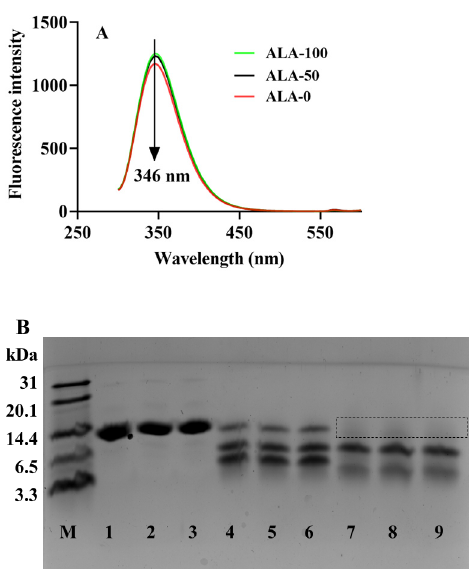
Figure 1. Influence of ultrasound on intrinsic fluorescence spectra of samples ( A ); the tricine SDS PAGE pattern ( B ) of ALA-0 (Lane 1), ALA-50 (Lane 2), ALA-100 (Lane 3), ALA-0G (Lane 4), ALA-50G (Lane 5), ALA-100G (Lane 6), ALA-0D (Lane 7), ALA-50D (Lane 8), and ALA-100D (Lane 9). ALA-0: untreated ALA, ALA-50: ultrasound-treated ALA at 50 W/cm 2 , ALA-100: ultrasound-treated ALA at 100 W/cm 2 . ALA-0G, ALA-50G, and ALA-100G: ALA-0, ALA-50, and ALA-100 digested by simulated gastric juice. ALA-0D, ALA-50D, and ALA-100D: ALA-0, ALA-50, and ALA-100 digested by simulated gastric juice followed simulated duodenal